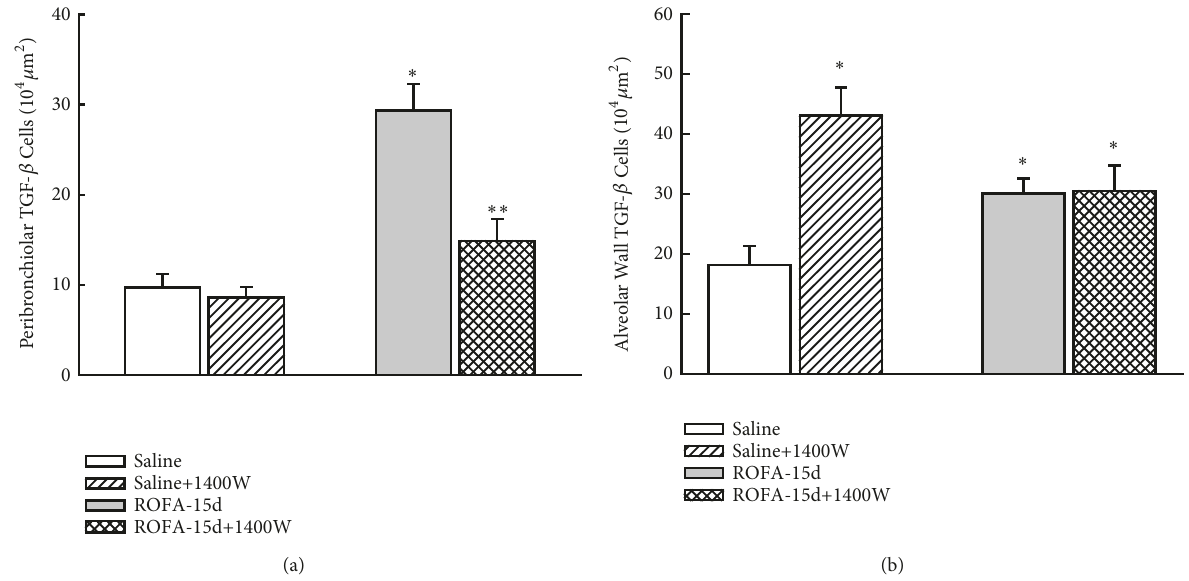
Figure 5: TGF- 𝛽 expression: this figurerepresentsthe mean and SEM values of TGF- 𝛽 expression in both peribronchiolar(a)and alveolar (b) wall. The ROFA instillations increased the numberof TGF- 𝛽 -positive cells in both airways and alveolar wall and iNOS inhibition reduced this response only in airways. ∗ p < 0.05 compared with saline groups; ∗∗ p < 0.05 compared with animals thatreceived ROFA and